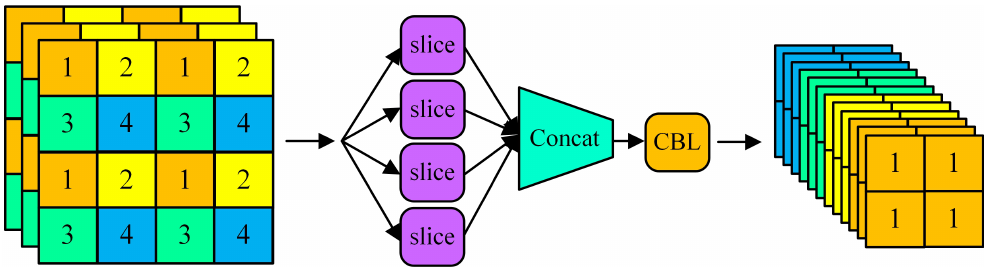
Figure 2. Focus module slicing